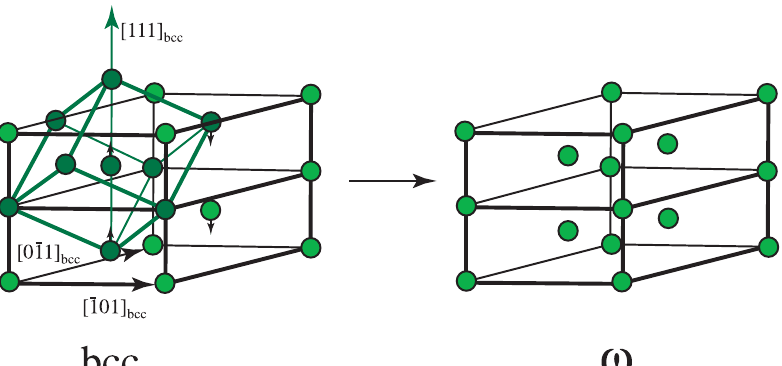
Fig. 7 The de Fontaine path between bcc and omega. The ω crystal structure can be formed from bcc by collapsing two out of every three bcc (111) planes 22 .